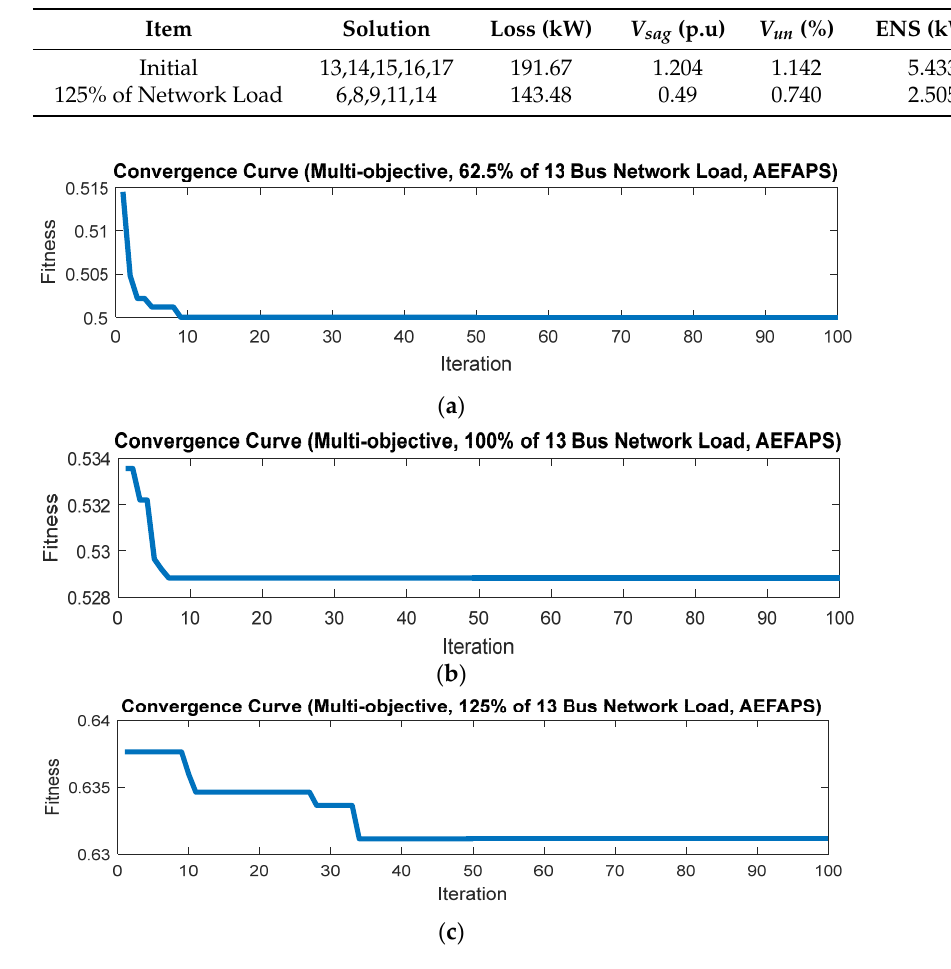
Table 9. The results of many-criteria reconfiguration of an unbalanced 13-bus network (125% of network load).